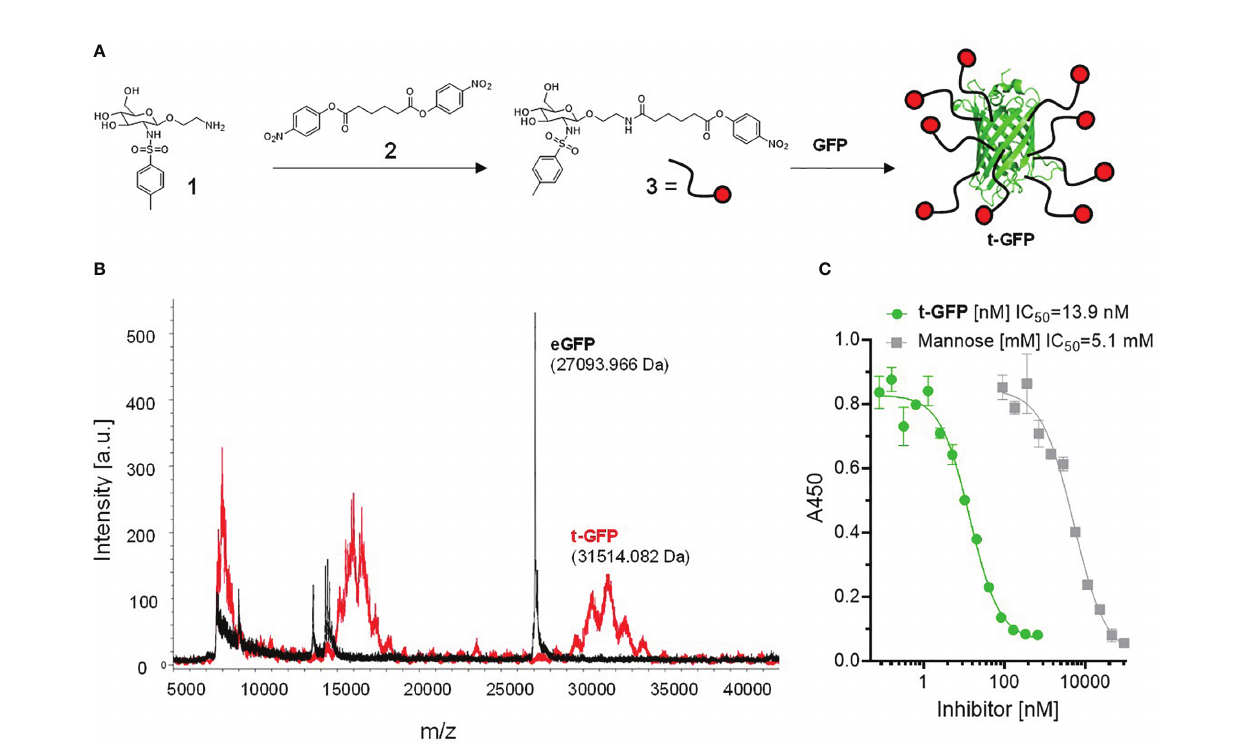
FIGURE 1 | Conjugation of Langerin targeting ligand to GFP: (A) preparation of active ester 3 and subsequent reaction to t-GFP. (B) Determination of coupling ef fi ciency by MALDI-TOF. The average m/z difference of GFP and t-GFP was divided by the molecular weight of the active ester 3 (minus the PNP leaving group). (C) ELLA showing inhibition curves of recombinant human Langerin binding mannan and t-GFP, graph shows n = 3 average ±